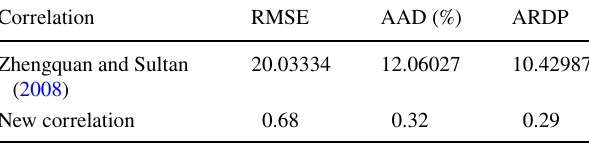
Fig. 15 Comparative scatter plots for “new correlation” and best-fitting correlations of Sangtam and Kumar Majumder (2018), Zhengquan and Sultan (2008), and Makogon (1981)